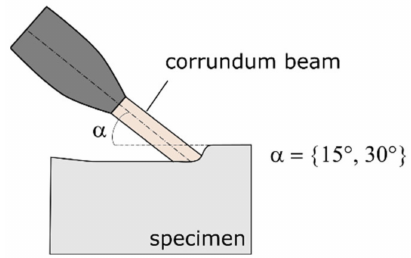
Figure 2. Schematic setup of the jet wear test for hard facings.